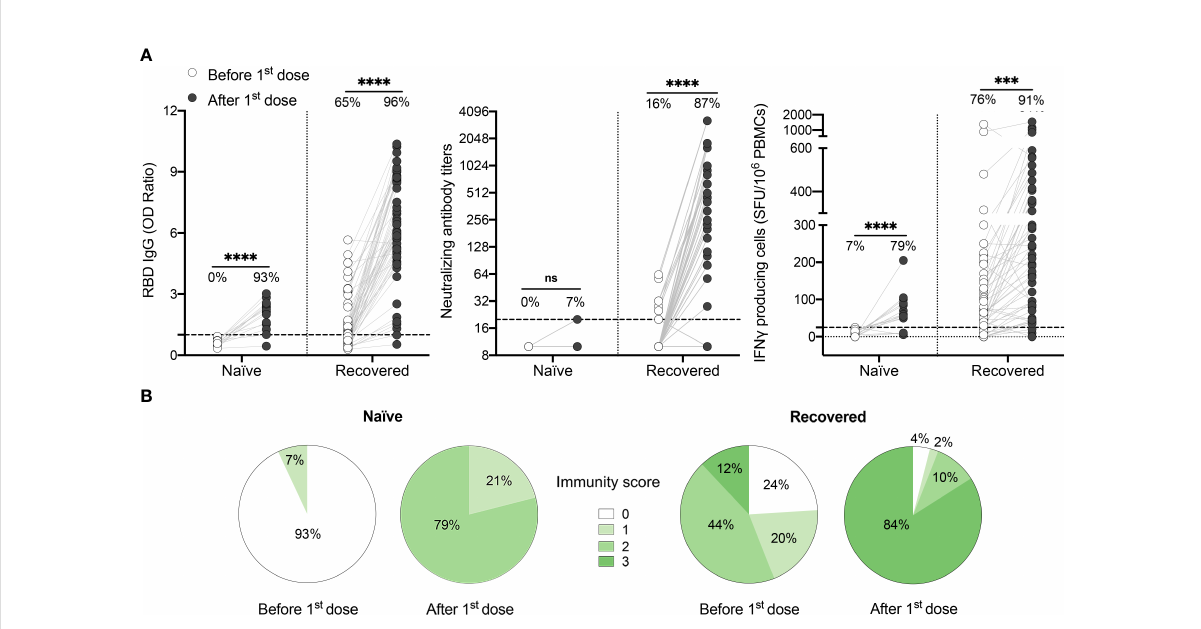
FIGURE 1 One dose of COVID-19 mRNA-vaccine strongly boosts SARS-CoV-2-speci fi c humoral and cellular responses in most HCWs who recovered from SARS-CoV-2 infection. (A) SARS-CoV-2 Spike RBD – speci fi c binding IgG levels assessed by ELISA (left panel), SARS-CoV-2 neutralizing antibody titers (middle panel), IFN- g secreting cells per million in response to SARS-CoV-2 Spike glycoprotein peptides (right panel) assessed by ELISpot for naïve (n=14) and recovered HCWs (n=55) before (white circles) and after one dose of vaccine (black circles). Dashed black lines indicate the positive threshold value, and the percentage of individuals with responses above positive threshold value is indicated for each time point. Statistical signi fi cance was assessed by Mann-Whitney tests. Not signi fi cant (ns) P >.05; ***P <.001; ****P <.0001. (B) Pie charts of calculated immunity score for naïve and recovered HCWs before and after one dose of